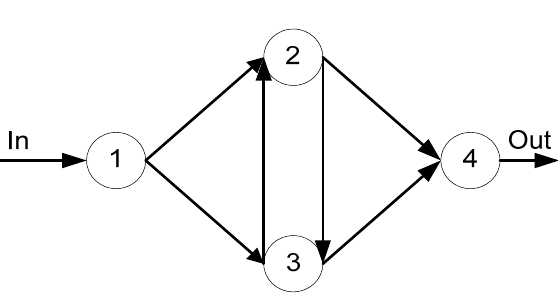
Figure 1. A typical network flow